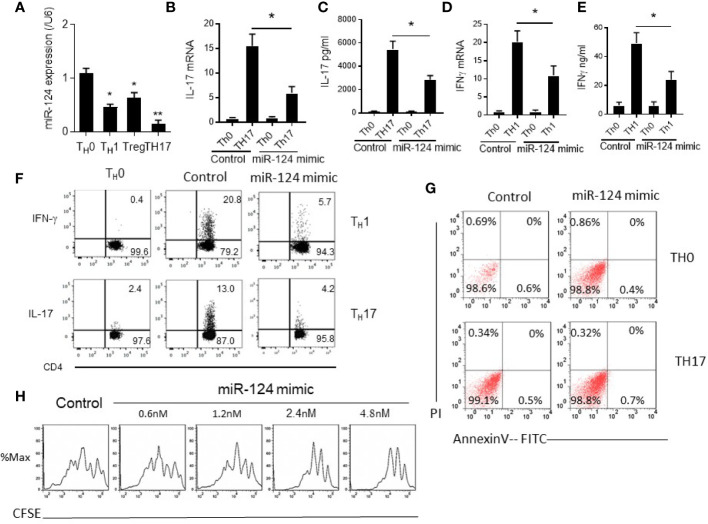
miR-124 selectively suppresses TH17 and TH1 cell differentiation. (A) miR-124 expression in TH0, TH17, TH1, and Treg polarizing conditions by qPCR assay. Naïve CD4+ T cells from C57BL/6 mice were differentiated under TH17 and TH1 polarizing conditions respectively in the presence of 4.8 nmol miR-124 mimic for 3 days and analyzed through qPCR assay (B, C). ELISA (D, E), and flow cytometry (F). (G) Naïve CD4+ T cells from C57BL/6 mice were differentiated under TH17 polarizing conditions respectively in the presence of 4.8 nmol miR-124 mimic for 3 days and analyzed through flow cytometry. (H) CD4+ cell proliferation was detected by CSFE. (G) Naïve CD4+ T cells from C57BL/6 mice were differentiated under TH17 polarizing conditions respectively in the presence of 4.8 nmol miR-124 mimic for 3 days, and stained with Annexin-V, analyzed through flow cytometry. *p < 0.05, **p < 0.01 versus cells cultured. All tests were performed three times.